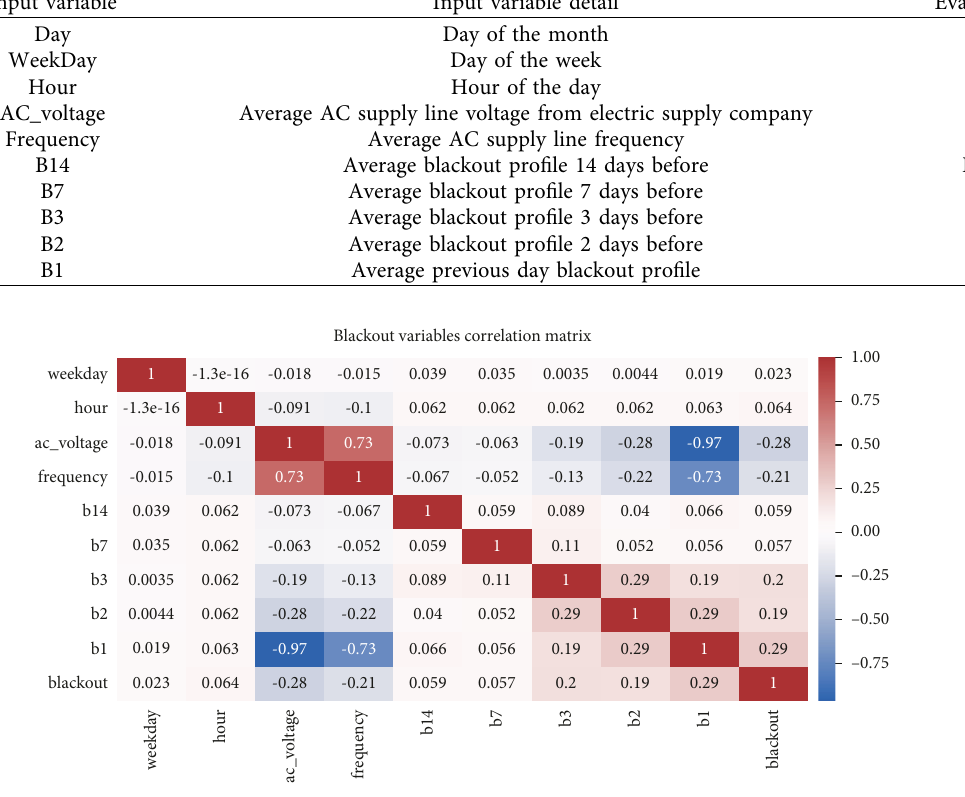
Figure 3: Input variables’ correlation to blackout variables. A value close to “1” signifies high correlation, whereas a value close to zero shows low correlation to the blackout variable. Negative values show a negative